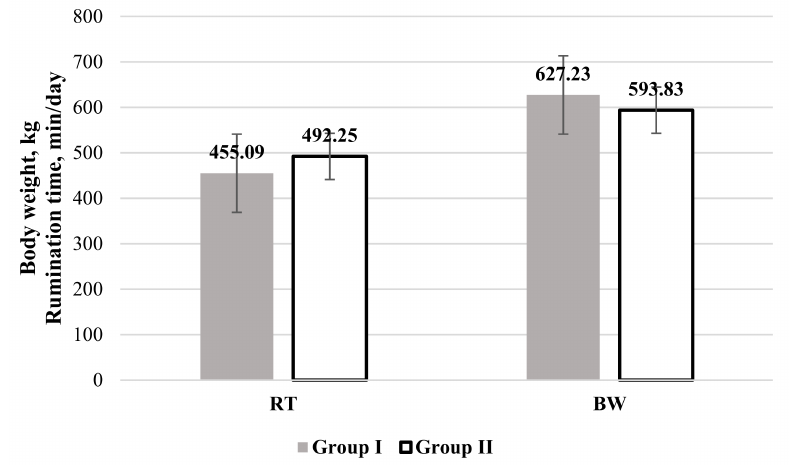
Figure 1. Rumination time (RT) and body weight (BW) in cows categorized by their non-esterified fatty acids (NEFAs) level. Group I: NEFA < 0.300 mEq/L; Group II: NEFA ≥ 0.300 mEq/L.